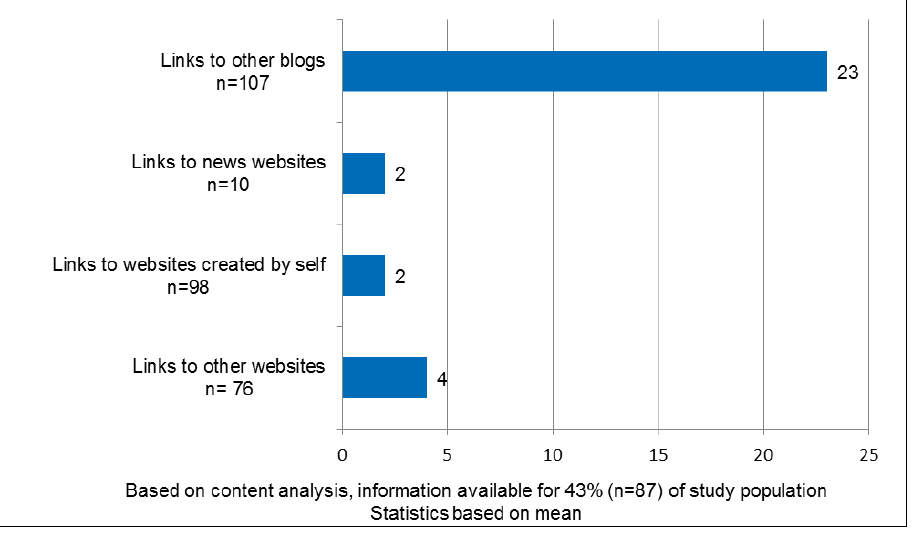
Figure 5: Sites Linked from Chinese